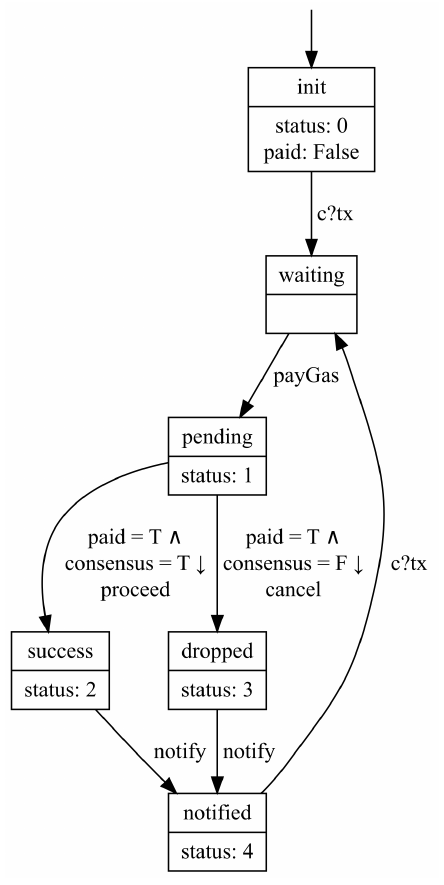
Figure 2. Visualized system graph of the transaction client in Example